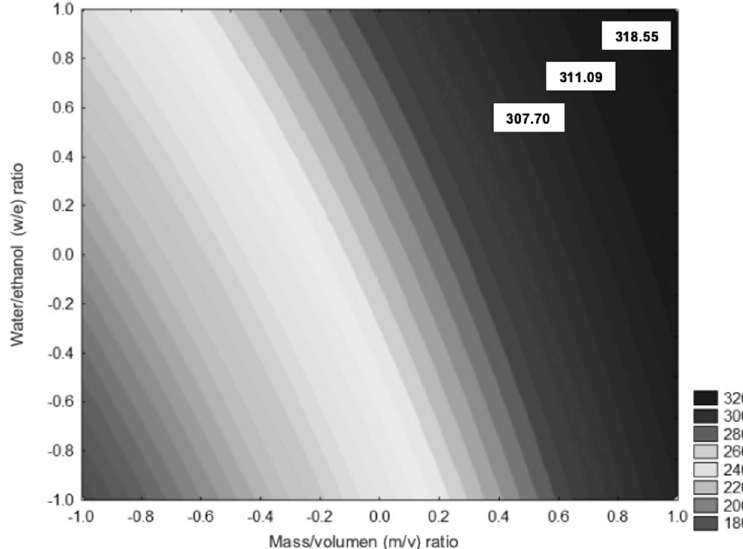
Figure 4. Contour diagram of the total polyphenol content in function of m / v ratio and w / e percentage. Polyphenol extraction ranges are between 180 and 320 mg / g of rambutan peel extract. The highest extraction conditions were 1:16-0 with 307.57 mg / g, 1:12-30 with 311.09 mg / g and 1:16-70 with 318.55 mg / g.